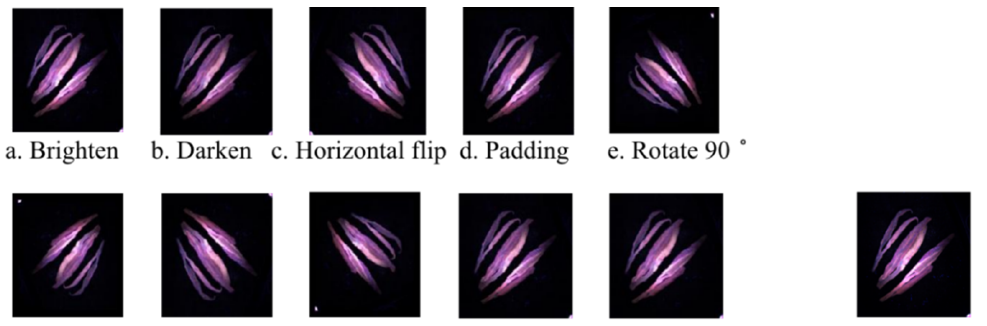
Figure 3. Methods and results of data augmentation transformation of different methods ( a – j ), and the original image ( k ).